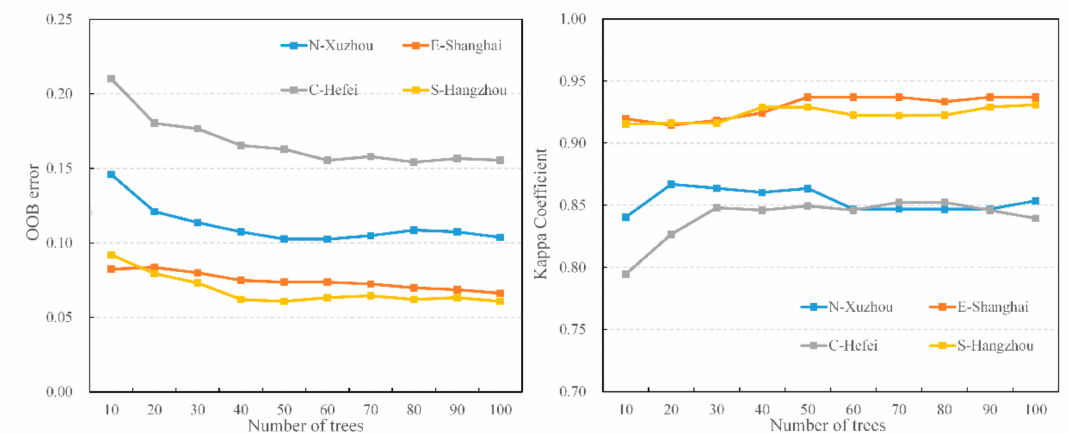
Figure 4. Impacts of di ff erent numbers of trees on the out of bag (OOB) error and the Kappa coe ffi cient in the four trained random forest classifiers in four training municipal districts. N-Xuzhou, E-Shanghai, C-Hefei, and S-Hangzhou represent Xuzhou in Northern Plain, Shanghai in East Coast, Hefei in Central Hills, and Hangzhou in Southern Mountain,